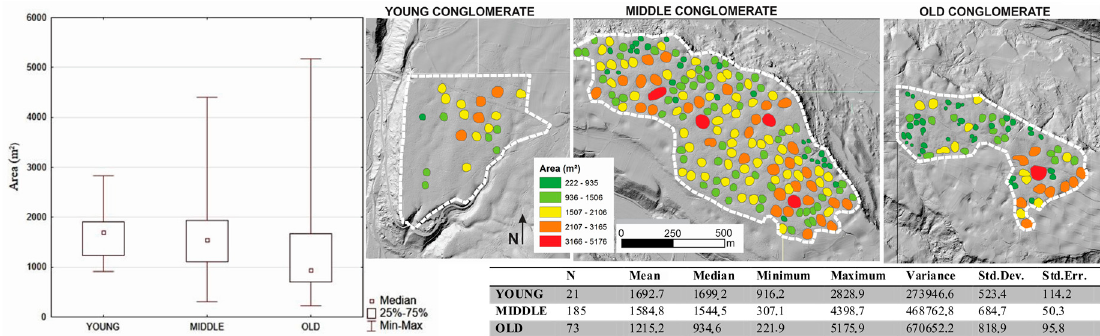
Figure 12. The area of a doline planar shape for conglomerates by age.